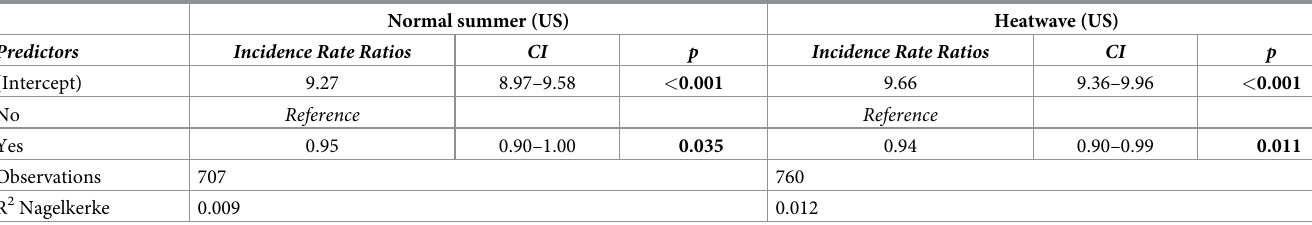
Table 4. Predicting number of overheating actions in the